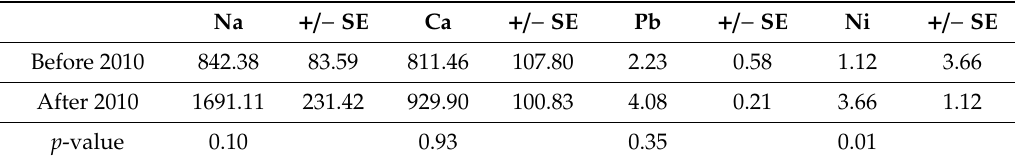
Figure 2. In graphs 2 a – d , values measured near and far the source of contamination are represented by a black-dashed line and by a grey-continuous line, respectively. In graphs 2 e – j , values measured in the dry and in the humid exposure conditions are represented by a black-dashed line and by a grey-continuous line, respectively. Statistical significance of differences between compared sets of data (Wilcoxon test p -values, significance level alfa at 0.05) are reported as asterisks. (*, p -value less than 0.05; **, p -value less than 0.01; ***, p -value less than 0.001) Table 4. Accumulation data (mg kg −1 ) measured before and after the start of the construction works (2010). Data are reported as mean values. Statistical significance of differences between compared sets of data are reported as Wilcoxon test p -values (significance level alfa at 0.05).